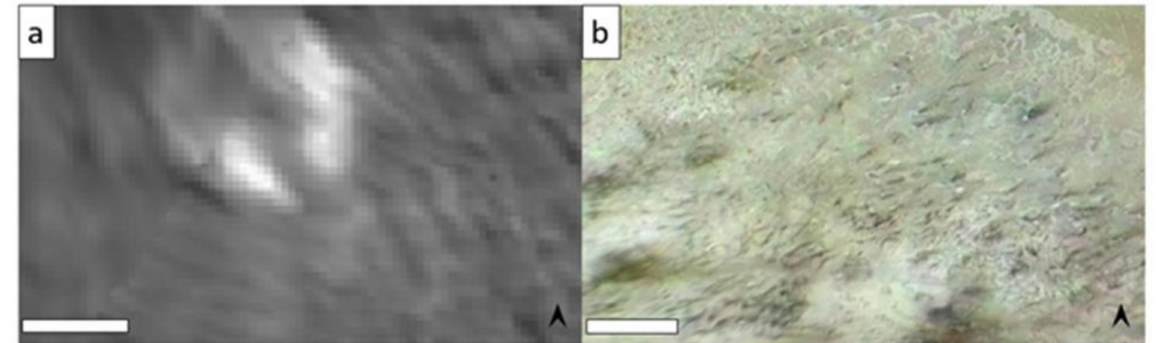
Figure 9. Voyager 2 images of CO 2 features on Uranian and Neptunian satellites. ( a ) Wunda crater CO 2 ice deposit (scale bar 75 km); ( b ) N 2 geysers with potential CO or CO 2 ice interactions at the southern pole of Triton (scale bar 250